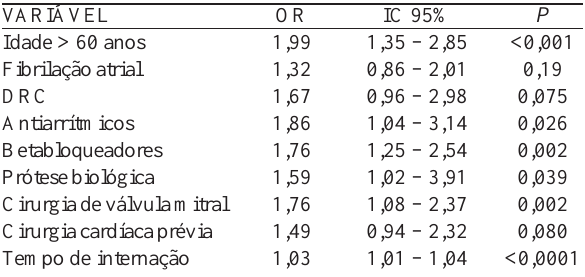
Tabela 3. Análise multivariada de fatores predisponentes ao BAV e uso de estimulação cardíaca artificial temporal no POCC